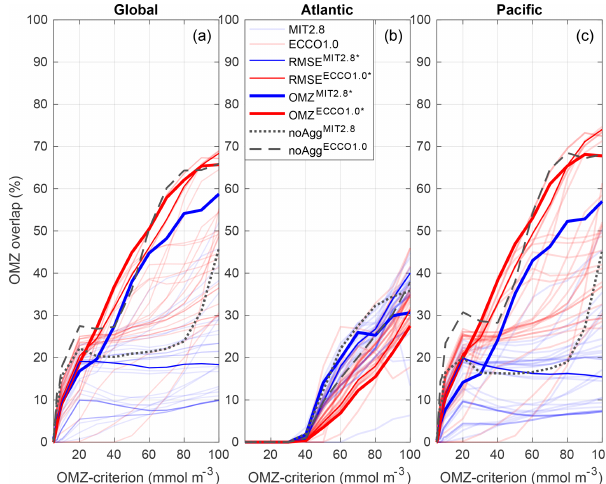
Figure 4. Overlap between modelled and observed OMZs (Eq. 2) for varying criteria c , ranging from 0 <c< 100mmolm − 3 ) on a global scale (a) , for the Atlantic Ocean (b) and for the Pacific Ocean (c)